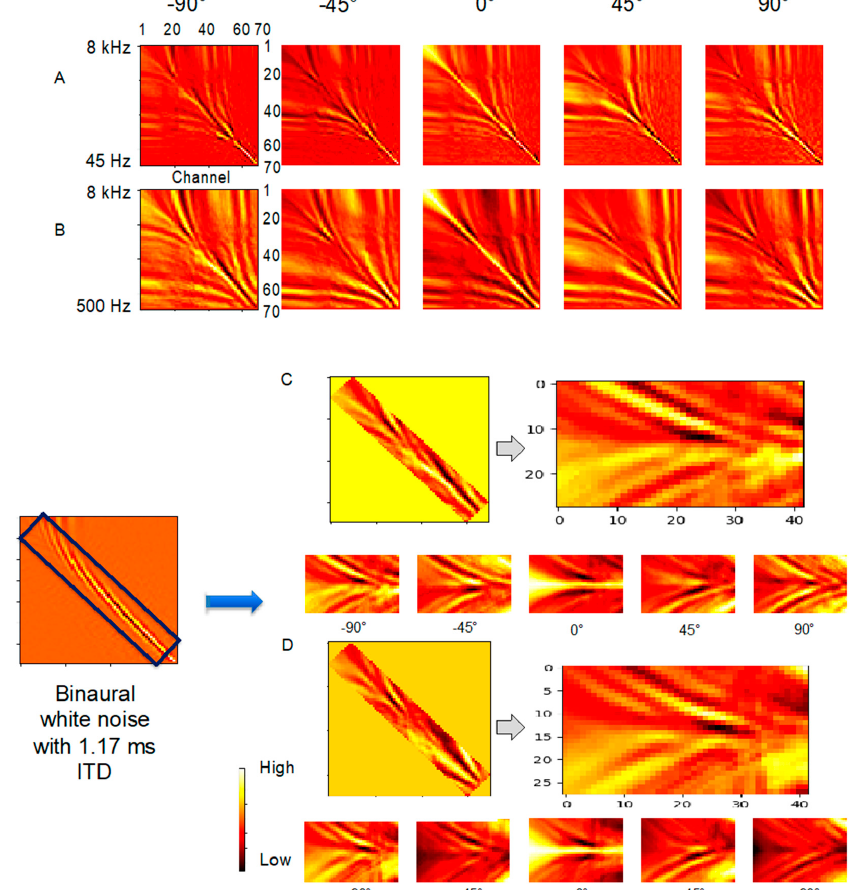
Figure 8. Onset correlogram generated from speech “eight”. ( A ) CAR-FAC filter CF frequency range is from 45 Hz to 8 kHz; ( B ) CAR-FAC filter CF frequency range is from 500 Hz to 8 kHz. Five azimuthal angles ( − 90 ◦ , − 45 ◦ , 0 ◦ , 75 ◦ , and 90 ◦ ) are shown here, and correlogram generated from a binaural white noise with 1.17 ms ITD (Bottom left) and (Bottom right) used as the input of the CNN. 14 channels on each side of the diagonal of the correlogram are selected, and the top left and bottom right of the correlogram are discarded to form a rectangular input to the CNN. ( C ) Diagonal correlogram of speech “eight” and ( D ) “zero” at location − 90 ◦ , − 45 ◦ , 0 ◦ , 45 ◦ , and 90 ◦